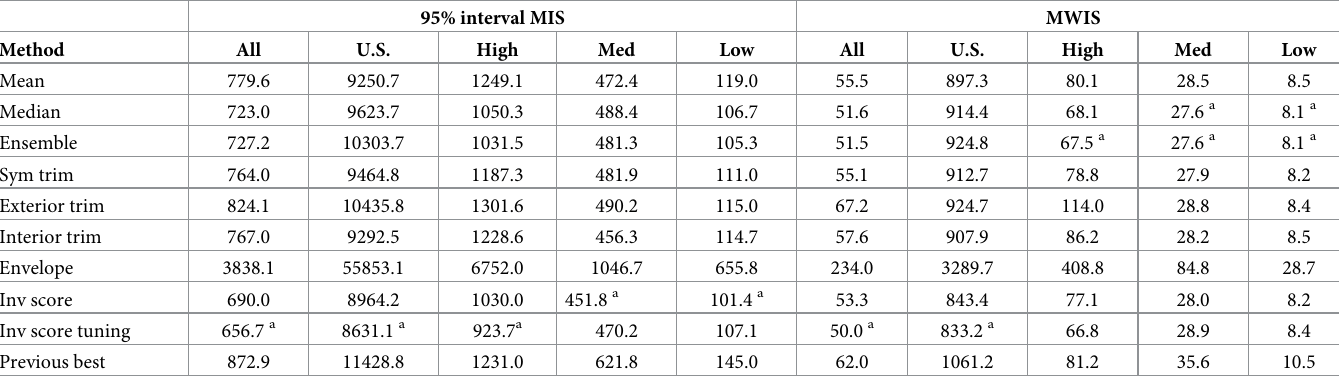
Table 1. For incident mortality, 95% interval MIS and